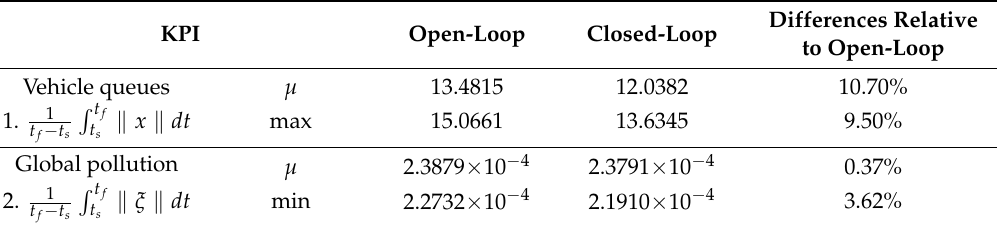
Table 4. KPIs for the evaluation of the control